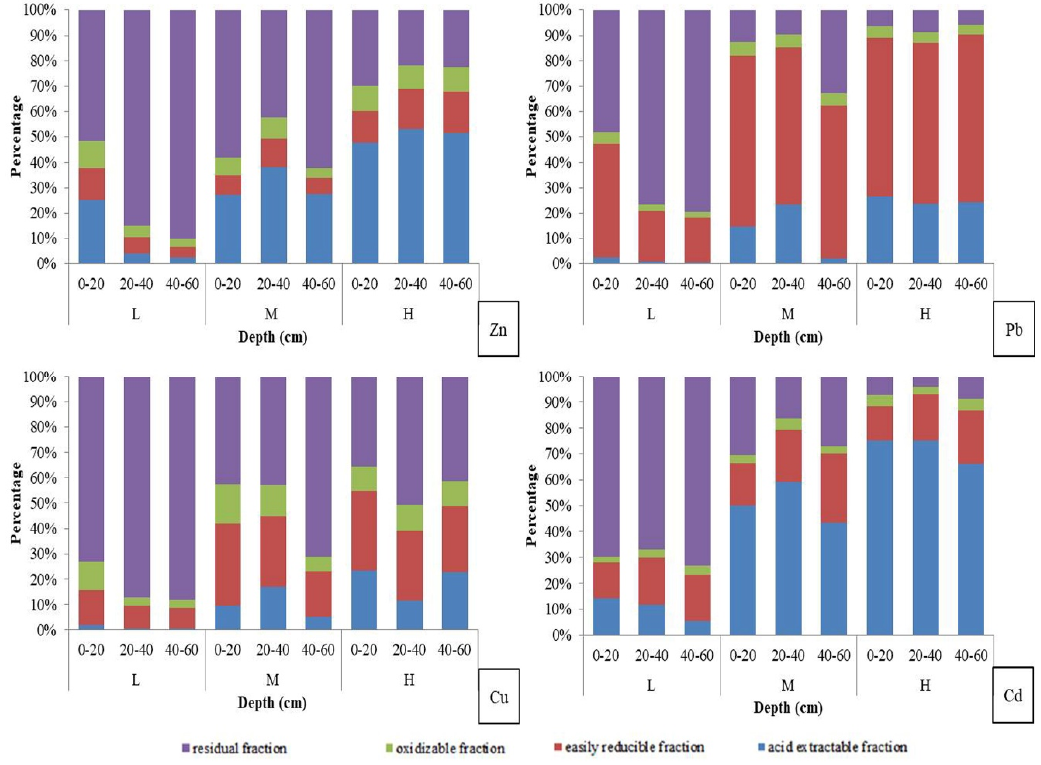
Figure 3. BCR (Community Bureau of Reference, European Commission) sequential extraction percentages of Zn, Pb, Cu, and Cd in different depths of L, M, and H area.